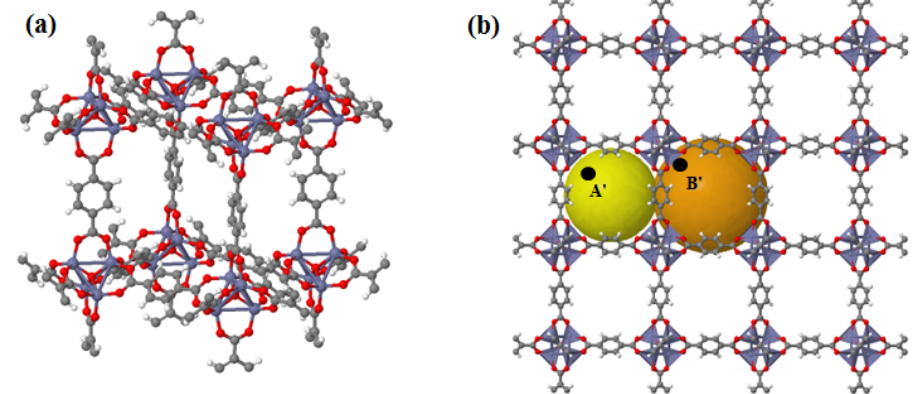
Fig. 1: (a) 1 by 1 by 1 MOF-5 framework, and (b) the small and large pores of MOF-5 framework (denoted as yellow and orange